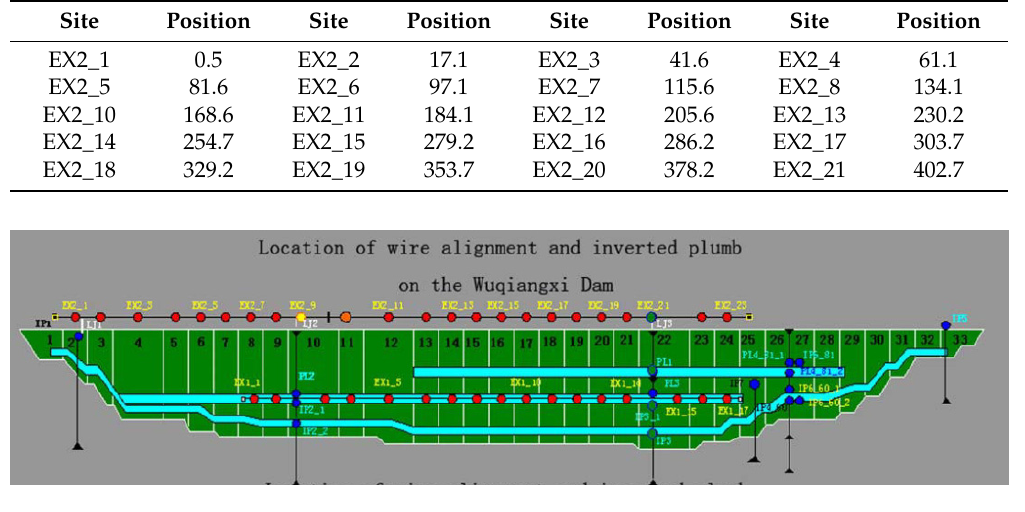
Figure 3. Location of the tension wire measuring points. The red points in the upper part show EX2 tension wire alignment measurement points; red points in the lower part show EX1 tension wire alignment measurement points; blue points are the inverted plumb measurement points.